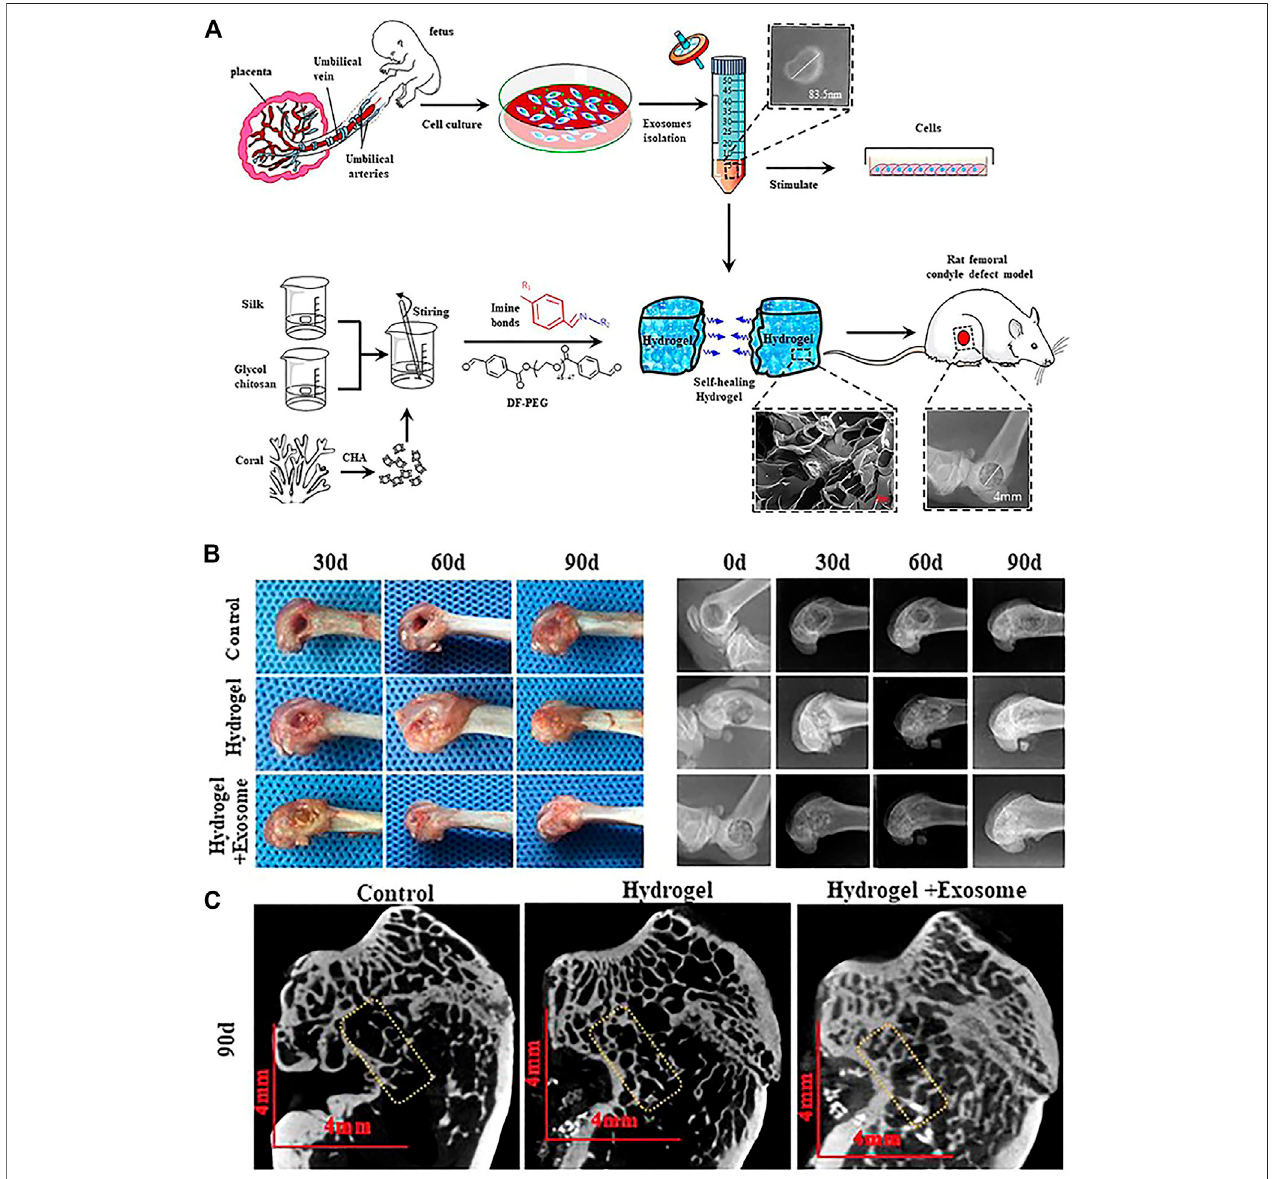
FIGURE 4 | Self-healing hydrogel containing exosomes (Wang L. et al., 2020). (A) Schematic illustration of the isolation and characterization of exosomes and preparationofself-healinghydrogelforapplyinginratfemoralcondyledefect. (B) GrossobservationandX-rayevaluationoftheeffectsofself-healinghydrogelcontaining exosomes. (C) Micro-CT evaluation of the effects of self-healing hydrogel containing exosomes.